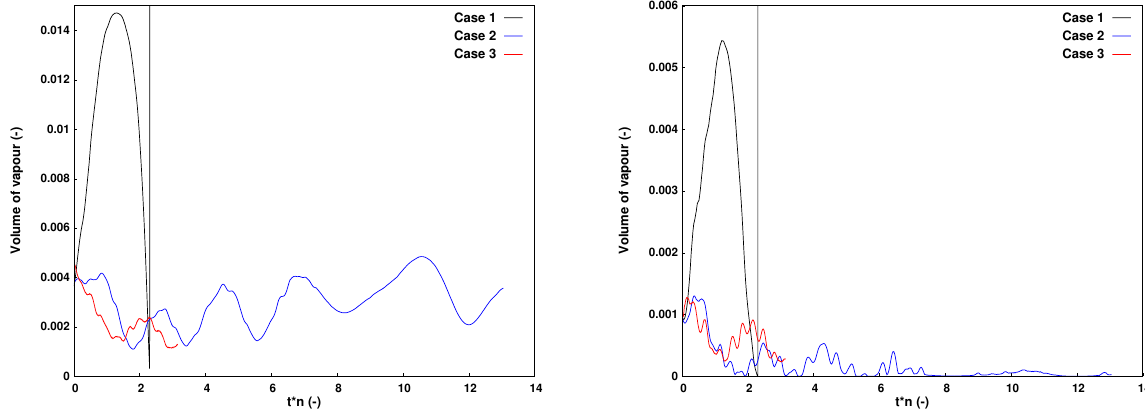
Figure 5. Time-history of the dimensionless volume of vapour in the runner (left) and in the draft tube (right). A Fourier analysis of the efficiency signal is shown in Figure 6 on the left. The fre- quency is divided by the runner frequency f n . The modes put in evidence are the ones associated with the blade passage frequency f b = 16 f n and the first and fifth harmonic. Both Case 2 and Case 3 capture the fifth harmonic, which corresponds to the rotor/stator interaction since 5 f b = 4 f gv = 80 f n . A Fourier analysis of the volume of vapour has also been carried out even if only the simulation Case 2 has achieved enough cycles to provide an estimation of the low frequency characteristic of the time evolution of the volume of vapour. By focusing only on Case 2 , a low frequency around 0.3 f n is put in evidence, which is closed to 0.25 f n , the value observed on the torque during the measurements